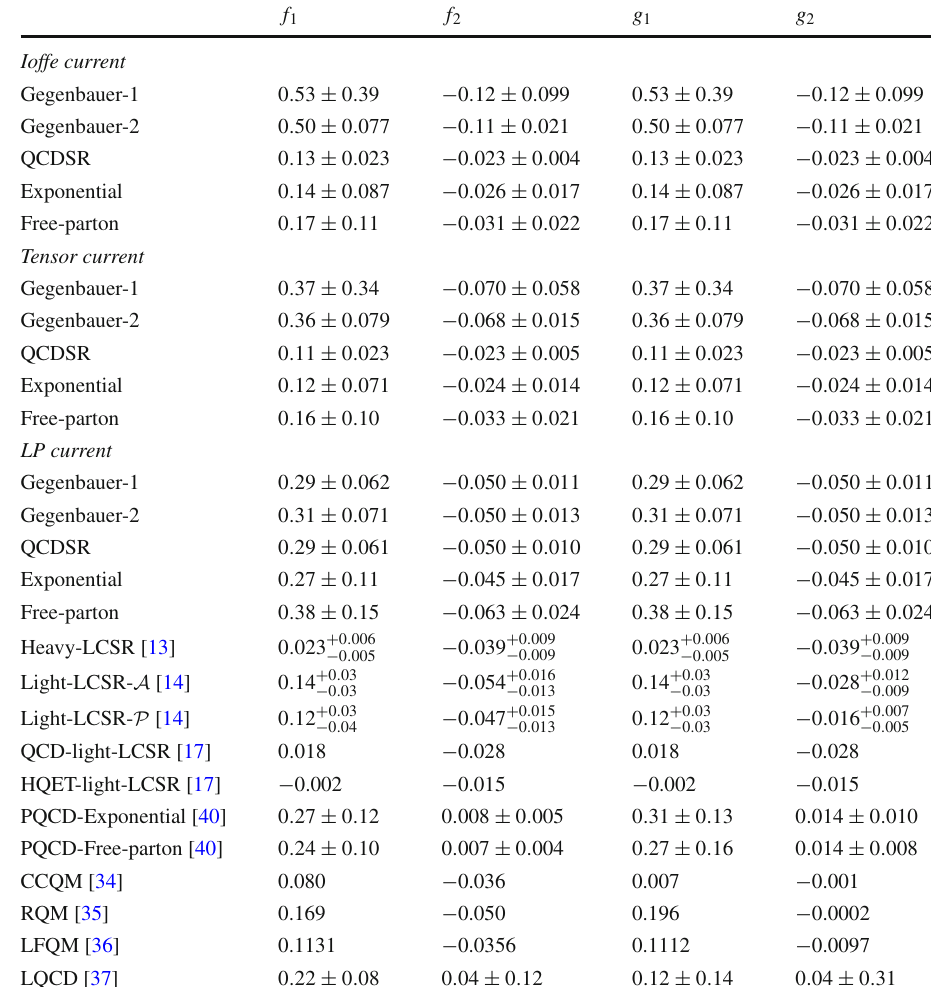
Table 1 The results of form factors f i and g i for (cid:2) b → p at q 2 = 0 under three interpolating currents for the proton(Ioffe, Tensor and LP) with five different LCDA models of (cid:2) b baryon(Gegenbauer-1, Gegenbauer-2, QCDSR, Exponential and Free-parton) in this work. The results for the form factor f 2 ( 0 ) and f 3 ( 0 ) are same, f 2 ( 0 ) = f 3 ( 0 ) , as well as for g 2 ( 0 ) and g 3 ( 0 ) . For comparison, we also collect the results of the form factors from other